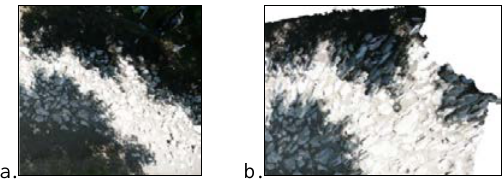
Figure 19. Orthomosaic of the